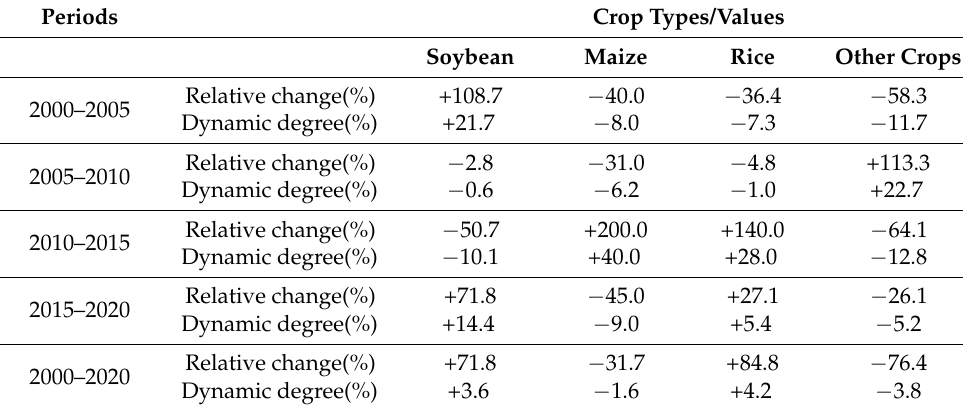
Table 3. Area changes of major crops in Hailun